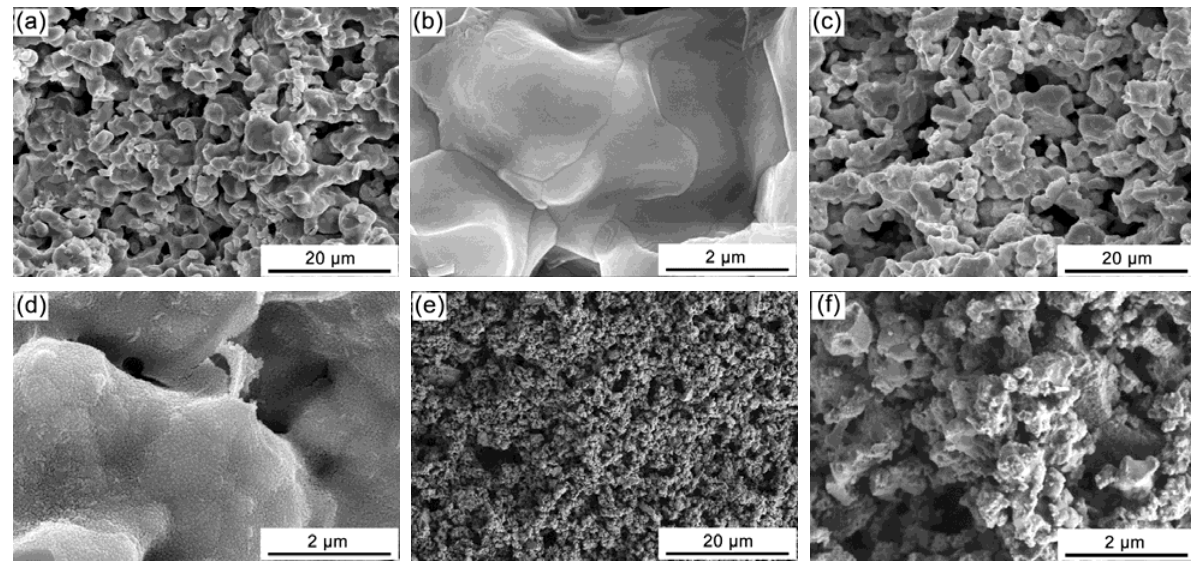
Fig. 3 (a) SEM image of porous Ce 0.9 Ca 0.1 O 2 − δ substrate and (b) higher magnification image. (c) SEM image of Ce 0.9 Ca 0.1 O 2 − δ substrate infiltrated with NiMo and (d) higher magnification image. (e) SEM image of thin NiMo–Ce 0.9 Ca 0.1 O 2 − δ layer from Cell A and (f) higher magnification image.